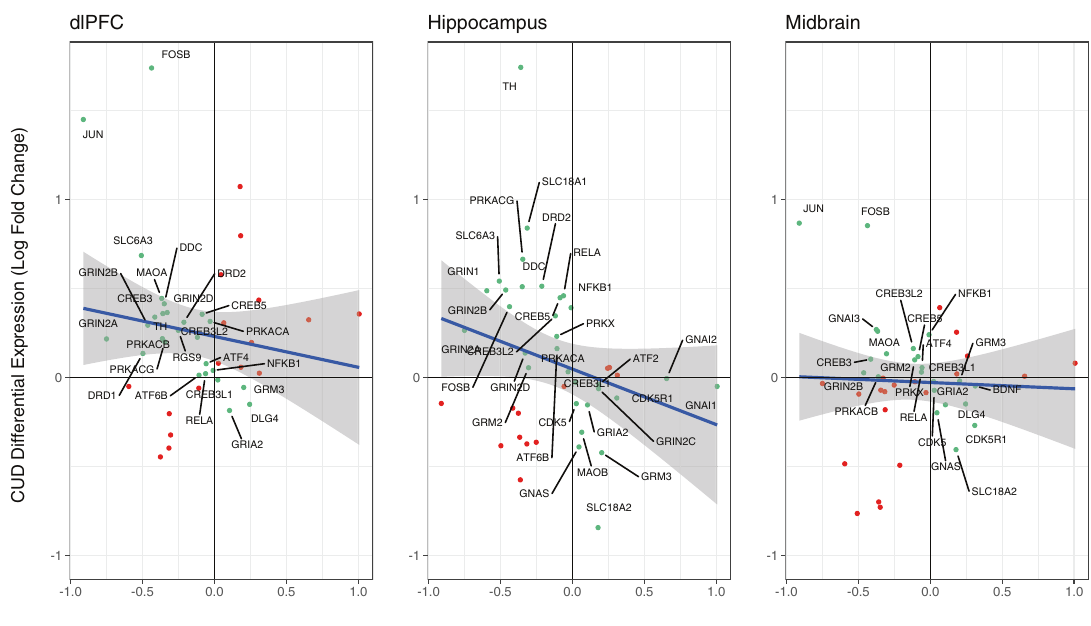
Fig. 4 Neuronal signatures of ibrutinib are negatively associated with cocaine addiction genes in the human brain. The blue line shows the best fi tting line and standard error between CUD gene expression (of KEGG Cocaine Addiction Pathway genes) and neuronal signatures of ibrutinib (collapsing across dose, time and cell line; r dlPFC = − 0.16, r hippocampus = − 0.25 and r midbrain = − 0.04). Genes were labeled if they were in the negative diagonal of the plot (green points). Differential expression of FOSB in the dlPFC was windsorized for visualization purposes.